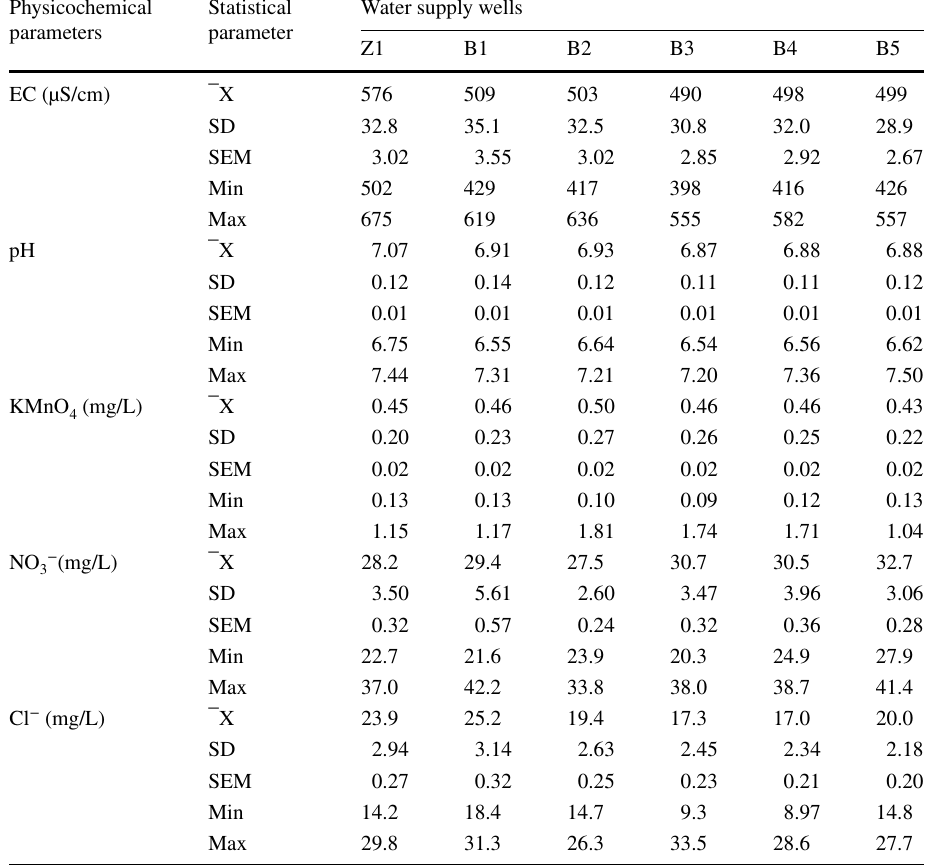
SD the standard deviation; SEM the standard error of mean; Min the minimum; and Max